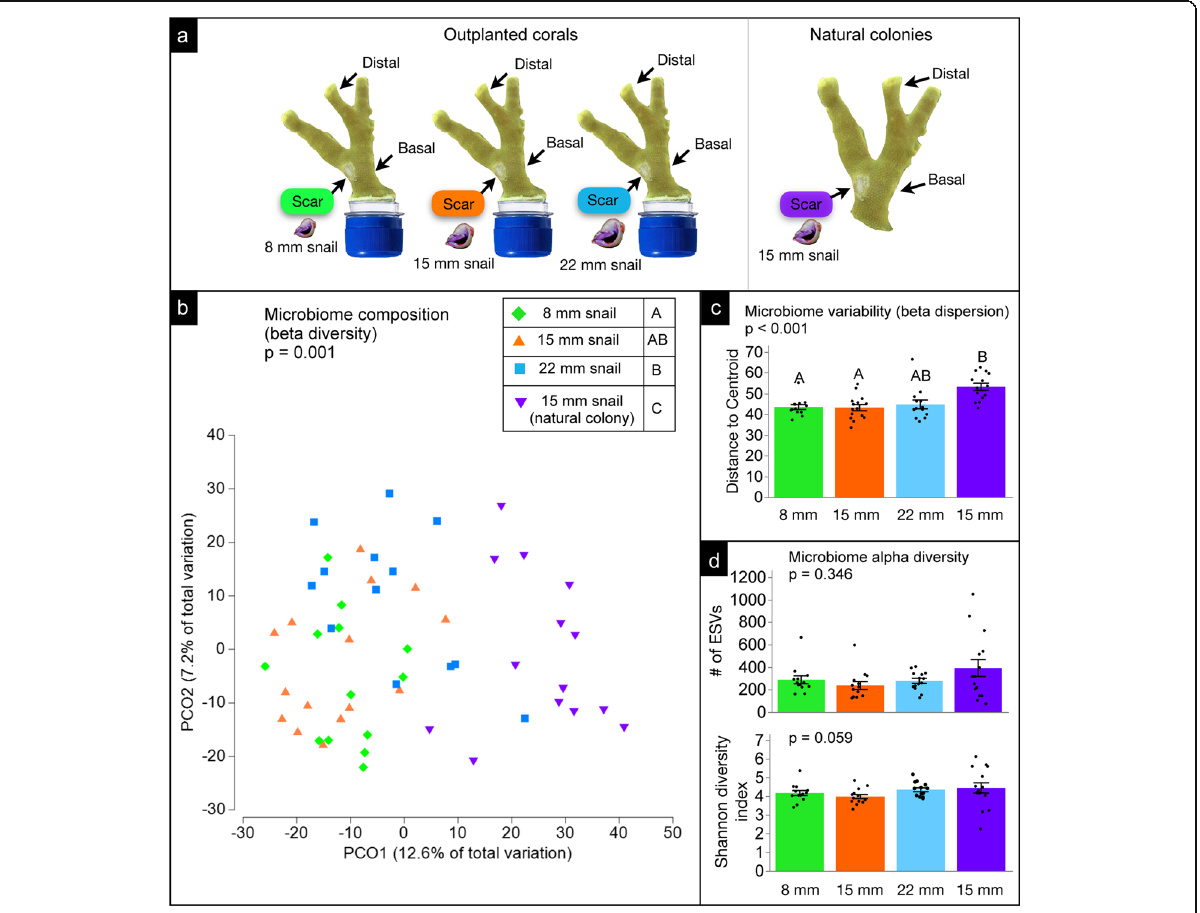
Fig. 1 Microbiomes of feeding scars. a Sampling schematic of scar locations from outplanted corals in our manipulative experiment and natural colonies in the field used for analyses (one-factor test, factor: treatment). b Microbiome composition (beta diversity) of scar samples among treatments. Letters in legend denote significant differences ( p < 0.01). c Microbiome variability (beta dispersion) of scar samples among treatments ( ⍺ = 0.025). d Microbiome alpha diversity of scar samples among treatments ( ⍺ = 0.025). Analyses were performed following rarefaction (subsampling without replacement) to a uniform sequence count of 8013 sequences per